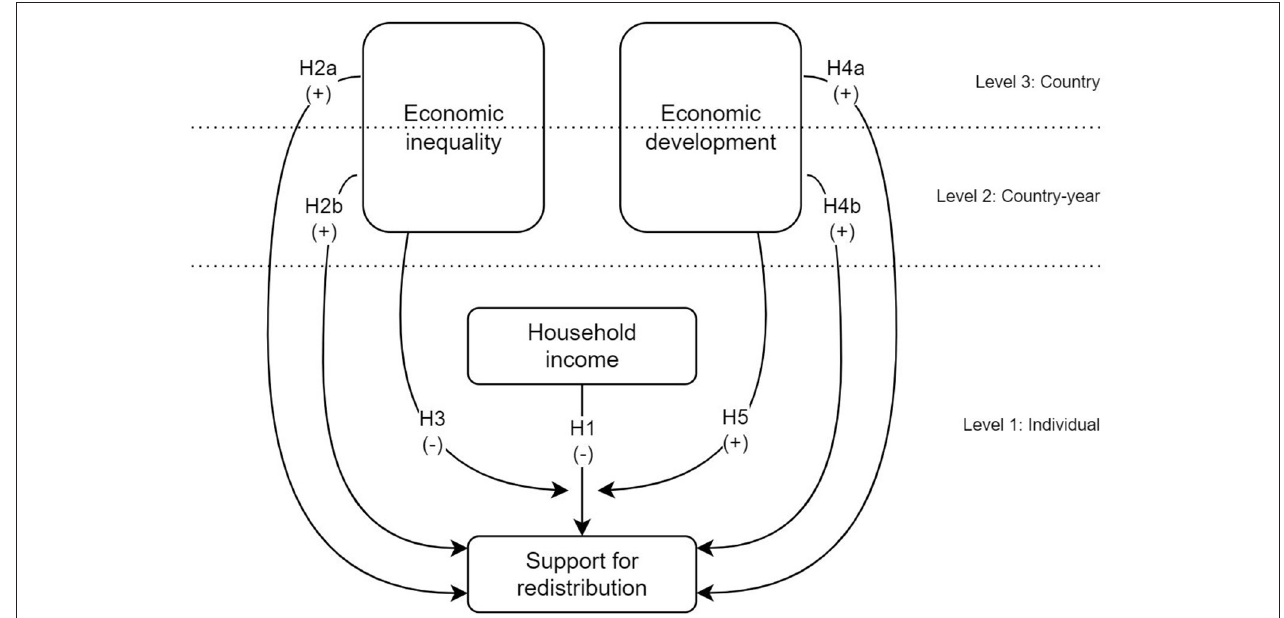
FIGURE 1 | Hypotheses